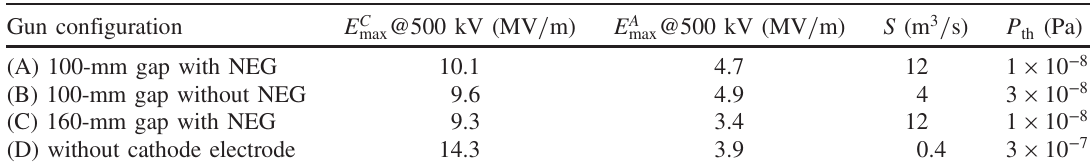
above which Eq. (4) is integrated for various gun th